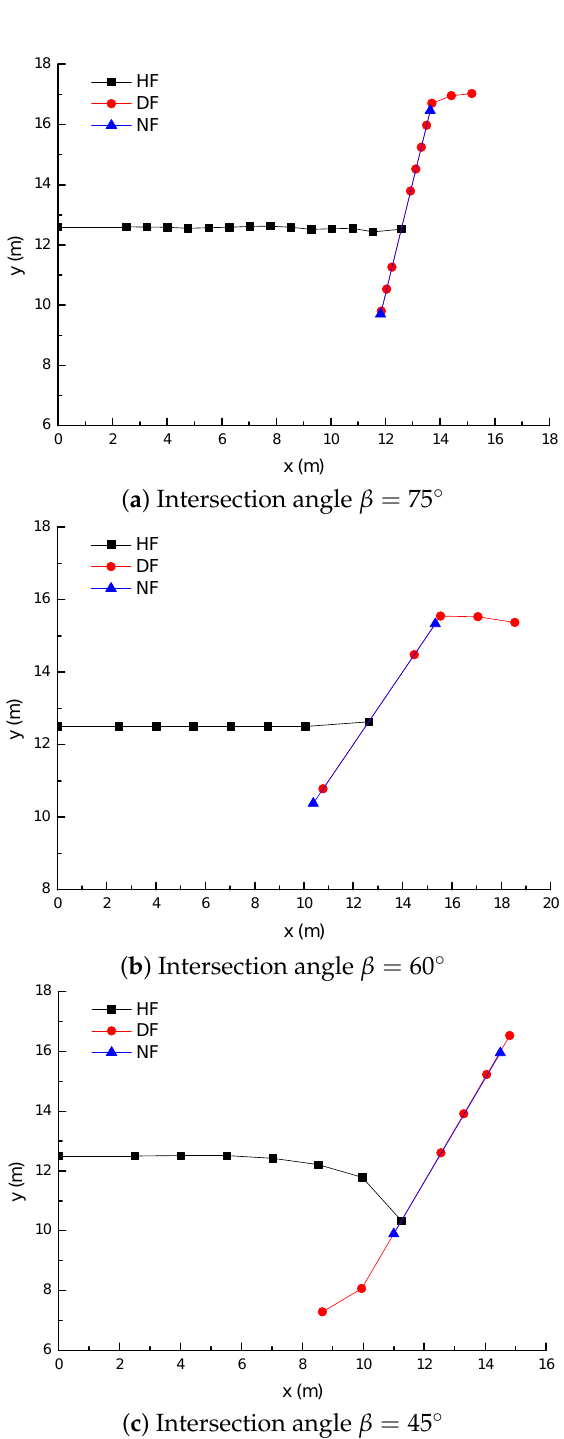
Figure 15. The crack propagation paths at different levels of intersection angle between HF and